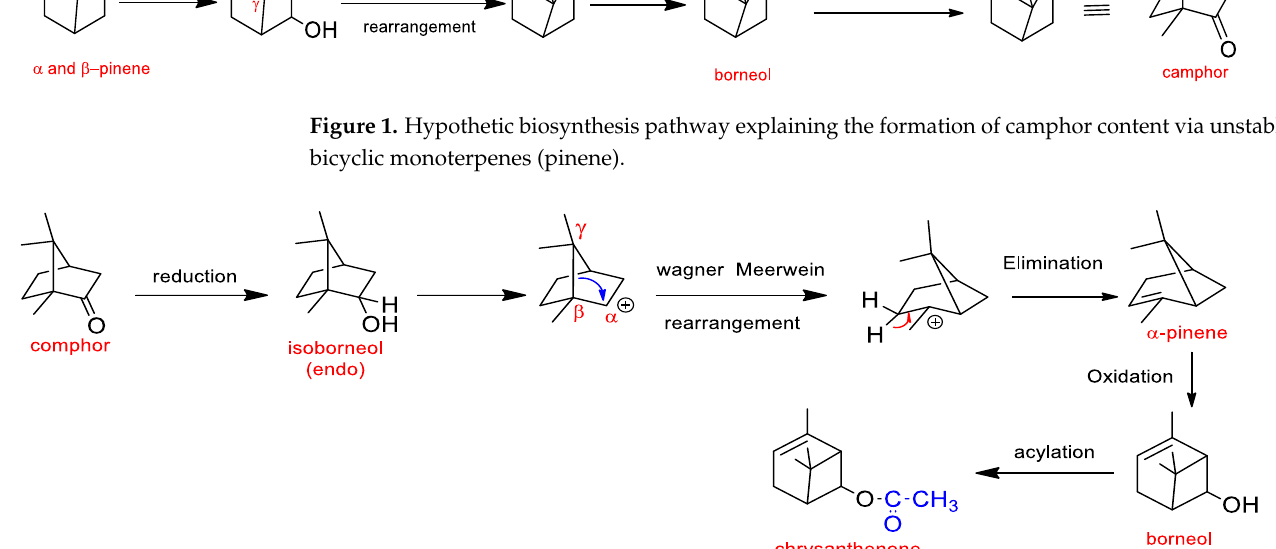
Figure 2. Proposed biosynthesis pathway showing the reduction in the content of camphor (June to September) and toward an increase in chrysanthenone fraction (June to September).